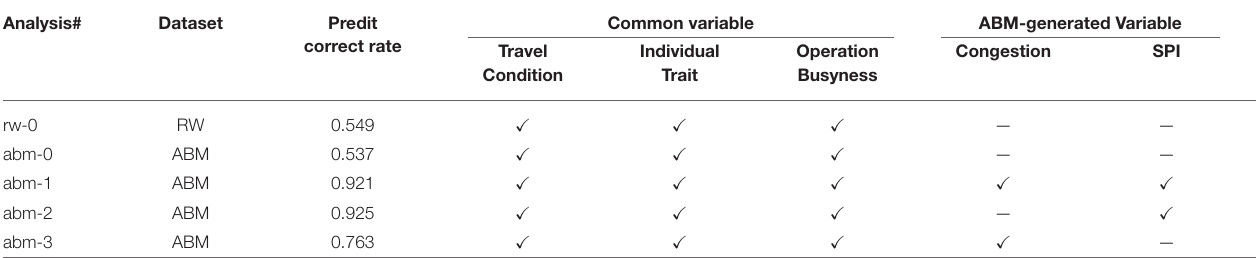
TABLE 5 | Summary of logistic regression analysis of experimental